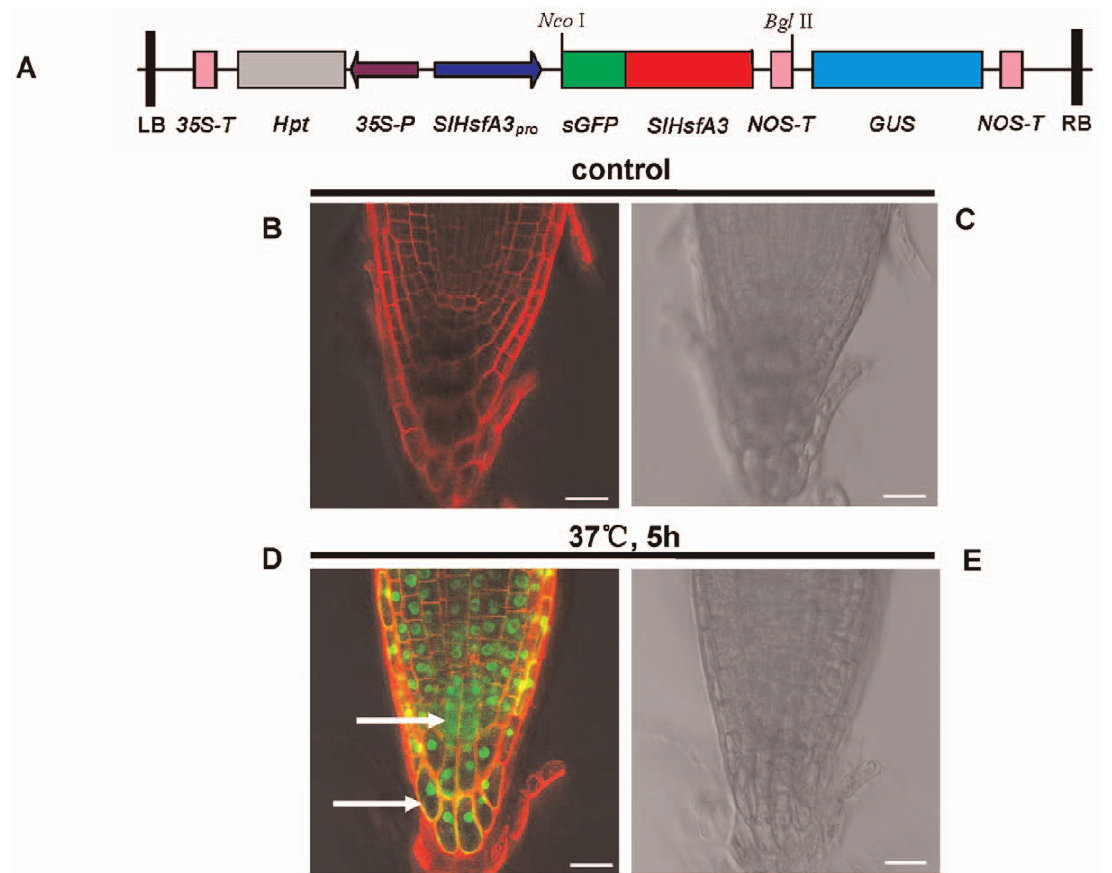
Figure 4. Subcellular localization of SlHsfA3-GFP fusion protein. (A) Schematic representation of construct used for Arabidopsis transformation. (B-E) The subcellular localization of SlHsfA3-GFP proteins in the root tips of transgenic Arabidopsis harboring SlHsfA3pro:sGFP-SlHsfA3 construct. The root tips of 5-d-old seedlings were observed with a confocal microscope before (B and C) or immediately after (D and E) incubation at 37 u C for 5 h. Bars =20 m m. The white arrows point to the cytoplasm and cell membrane, respectively. Propidium iodide staining was used to assess plasma membrane integrity (B and D).